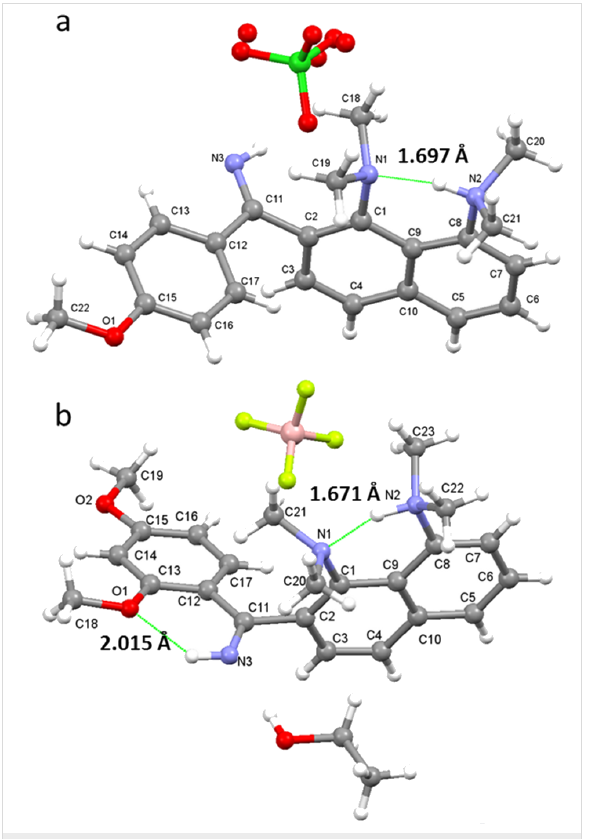
Figure 6: Molecular structure of protonated imines 4a · HClO 4 (a) and 6b · EtOH (b).